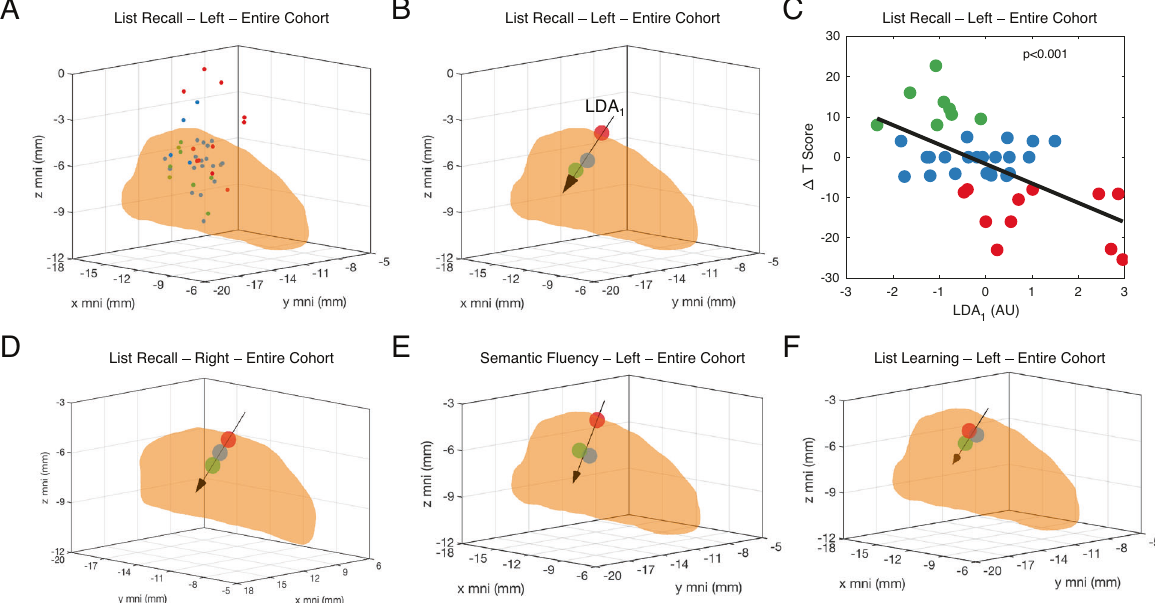
Fig. 2 Relationships between active contact location and post-DBS cognitive change for the entire cohort. A Active contact location in MNI space for the left STN for all 42 patients at the time of postoperative neuropsychological testing strati fi ed into three classes according to change in postoperative performance (postoperative worsening — red; no postoperative change — blue; postoperative improvement — green) on the list recall task, a measure of memory. B Mean contact location in MNI space for each of the three classes is identi fi ed with superimposed vector (LDA 1 ) that maximizes both the variance of the data and the separation among the classes as determined by linear discriminant analysis (LDA). C Plot of change in postoperative test performance in relationship to the axis identi fi ed by the LDA vector reveals a signi fi cant linear correlation. D – F Mean contact location in MNI space for each of the three outcome classes is plotted along with the LDA vector for the list recall task for the right STN ( D ), the semantic fl uency task, a measure of language, for the left STN ( E ), and the list learning task, another measure of memory, for the left STN ( F MNI coordinate space (LDA 1 arrow in Fig. 2B). LDA was chosen for each NPT measure (Fig. 2A). Next, we plotted the mean spatial because it takes class variability into account when reducing location of each of these classes (larger red, green, and blue circles dimensionality of a dataset, whereas more traditional principle in Fig. 2B) and used LDA to determine the vector that both best component analysis does not. Each of the 42 active contact explained Δ T variance and maximized class-to-class variability in locations (Fig. 2A) then was projected and normalized onto the